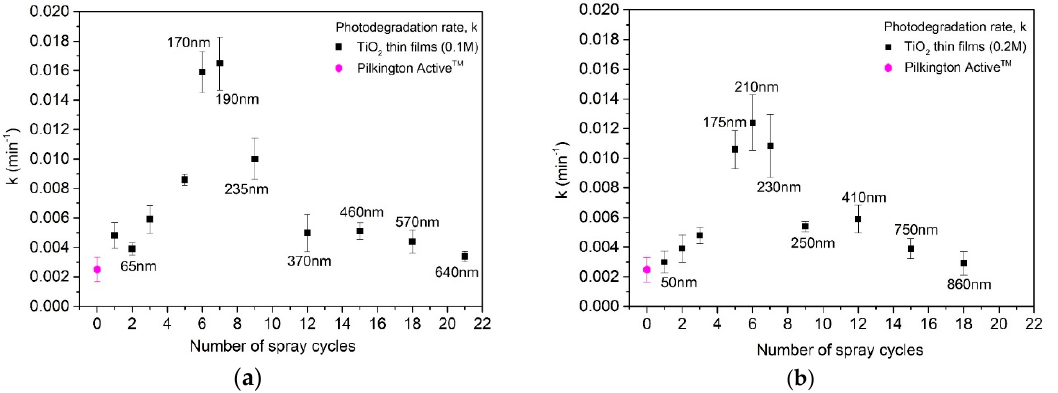
Figure 8. Photodegradation rate constant (k) values (standard errors shown by error bars) for the TiO 2 films deposited from solution with a concentration of ( a ) 0.1 M and ( b ) 0.2 M as a function of the number of spray cycles and film thicknesses. Film thicknesses are obtained by UV-Vis spectroscopy (Figure 5).